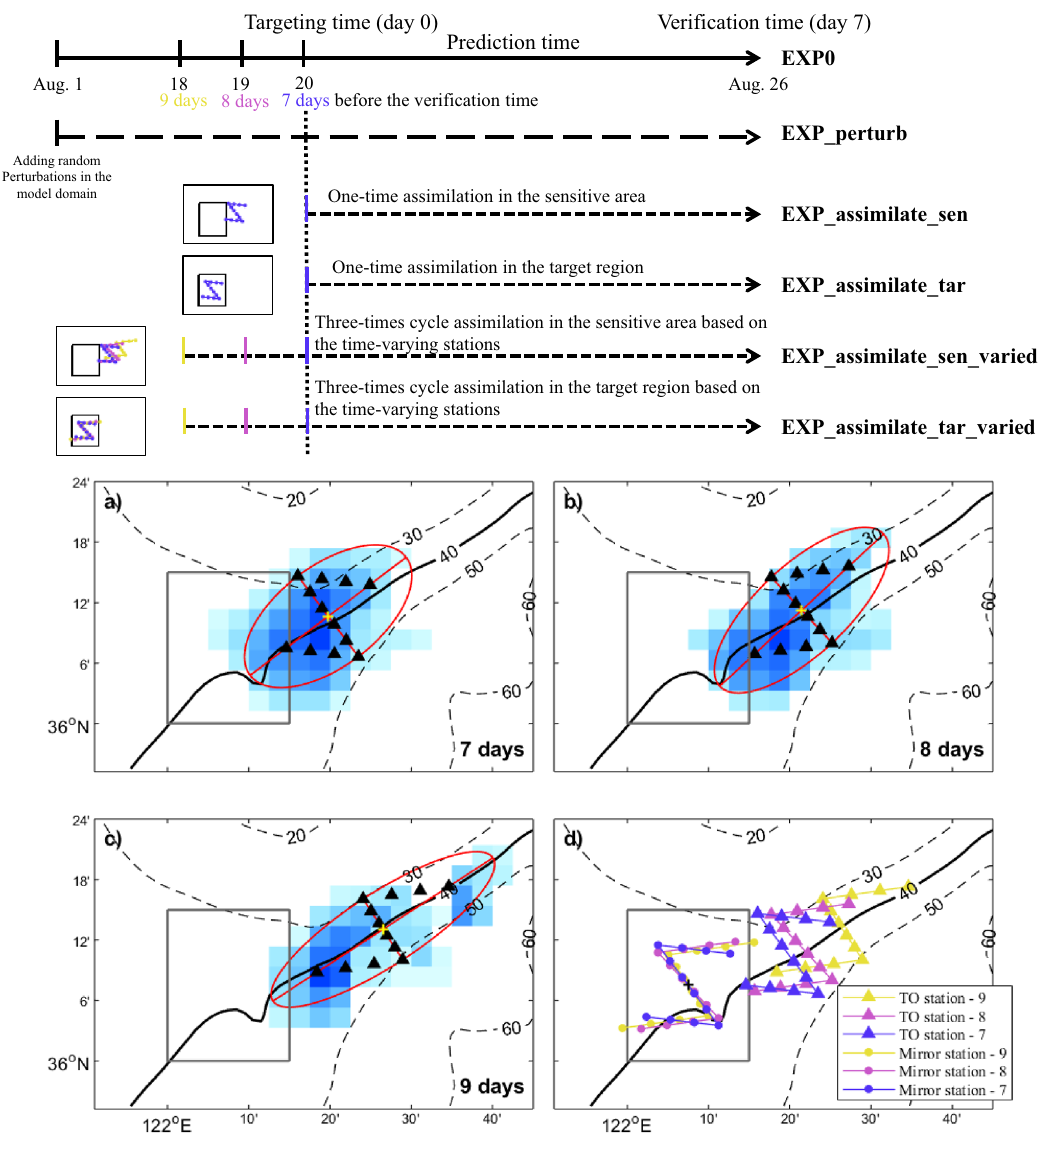
Figure 6. Schematic diagram of the Observing System Simulation Experiments based on the last climatology run. All the assimilation experiments use the results of the nature run as synthetic observations. The assimilated data station locations and the corresponding assimilation times are plotted by the same colors. ( a – c ) Z-shape observation stations (black triangles) designed based on the time-varying sensitive areas (background colors). The red ellipses are fitted to represent the most of the sensitive areas, which are used in the stations design. The gray box indicates the location of the target region. ( d ) The triangle stations denote the targeted observation (TO) stations, their locations are the same as those in ( a – c ), the circle stations indicate the corresponding mirror stations inside the target region. The different deployment times of the observations are distinguished by different colors. Figures are plotted using MATLAB R2017a (http:// www. mathw orks. com/) and Microsoft PowerPoint 2016 (https:// office. live. com/ start/ Power Point.